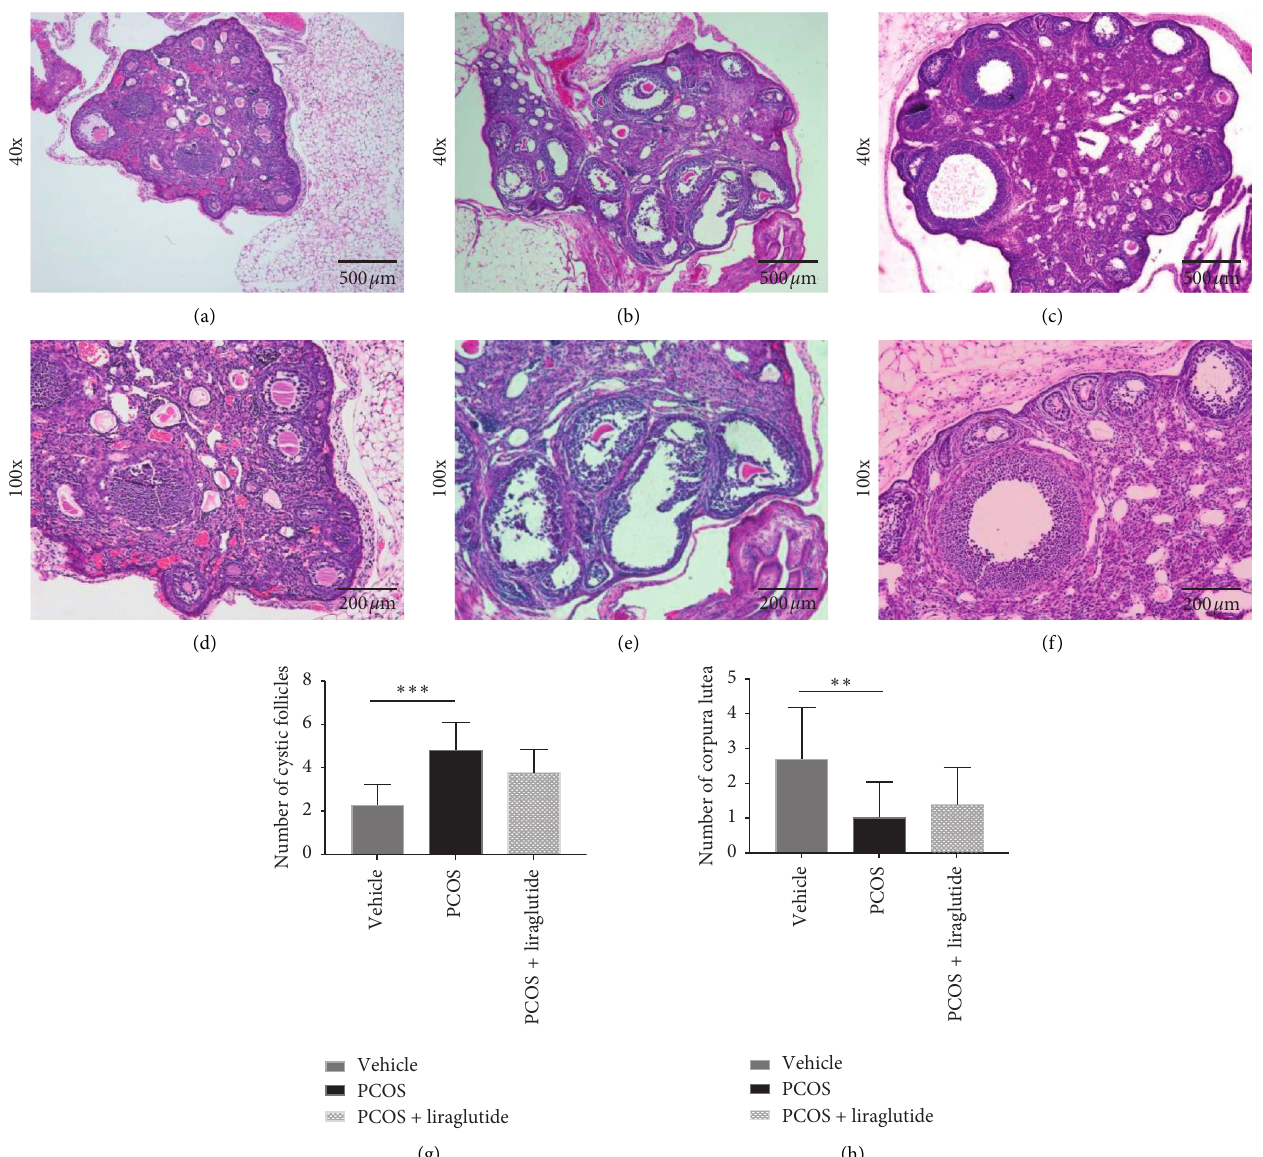
Figure 2: Ovarian histopathology changed in PCOS model mice with or without treatment of liraglutide. H&E staining of thin sections of ovaries from mice of three groups, PCOS +liraglutide (c, f), PCOS (b, e), and vehicle (a, d). Micrographs were taken at magnifications: × 40, × 100, and scale bars represent 500 μ m and 200 μ m, respectively. The numbers of cystic follicles (g) and corpora lutea (h) were counted based on the images after staining. The data were expressed as mean ± SEM ( N � 10/group). ∗ P < 0 . 05, ∗∗ P < 0 . 01, and ∗∗∗ P < 0 .